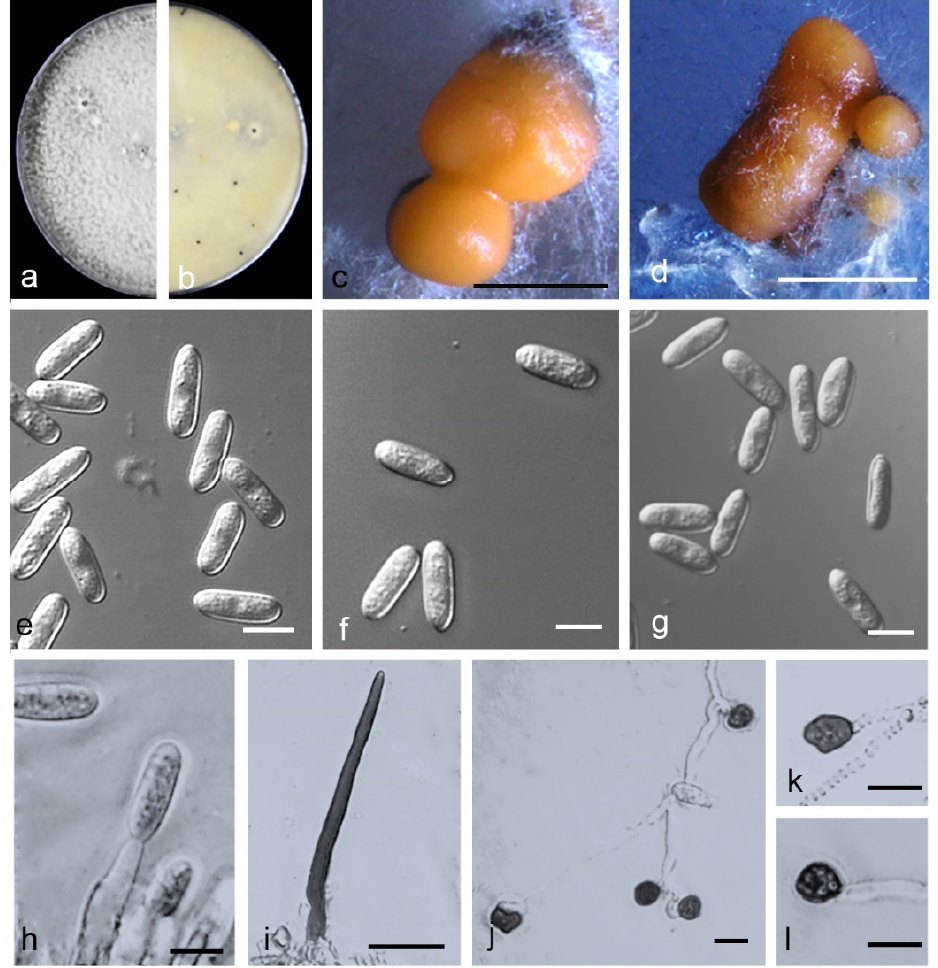
Figure 13. Colletotrichum citrulli . ( a , b ) Front and back view, respectively, of 9-d-old PDA culture; ( c , d ) conidiomata; ( e – g ) conidia; ( h ) conidiophores; ( i ) seta; ( j – l ) appressoria; ( a – q ) isolate CAASZT52; ( a , b ) produced on PDA agar medium; ( c , e – h ) produced on OA agar medium; ( d , i – l )